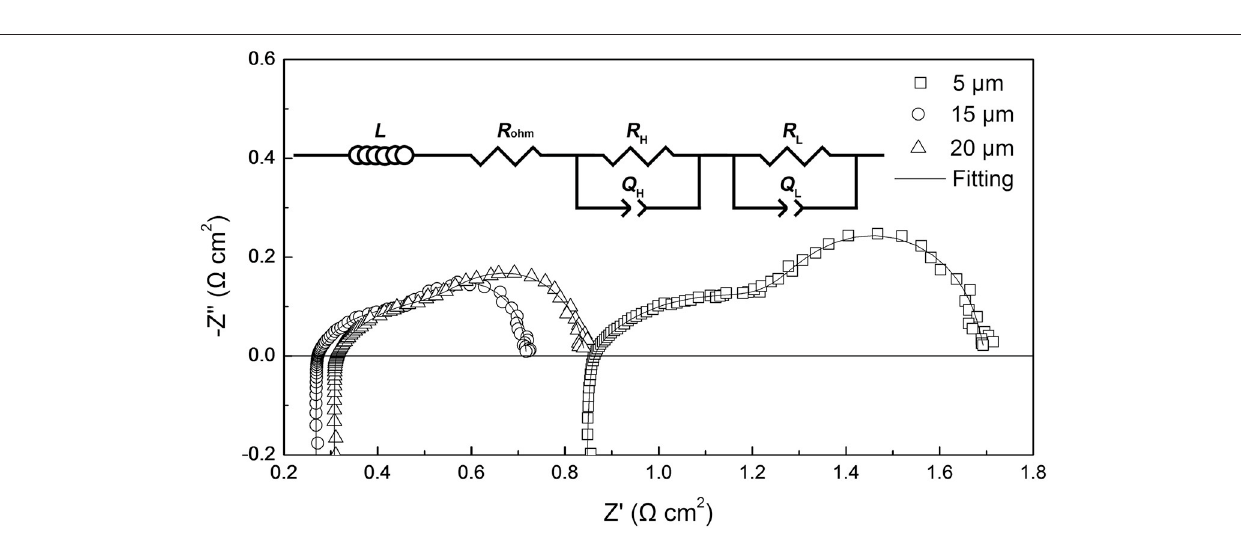
FIGURE 5 | Nyquist plots of the tubular single cells at 800 ◦ C under the OCV